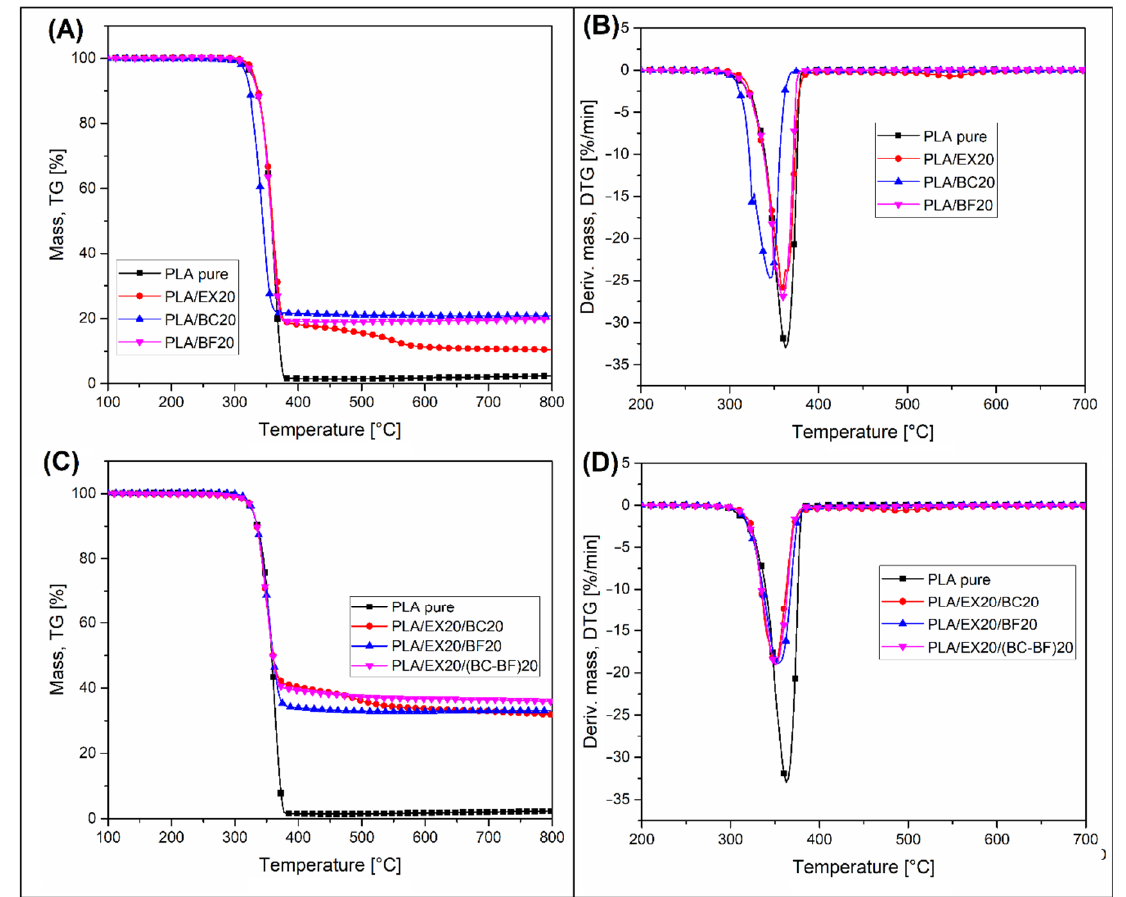
Figure 4. The thermogravimetric (TGA) analysis of PLA-based samples. Results are presented in the form of weight loss TG ( A , C ) and derivative weight loss plots DTG ( B , D ).